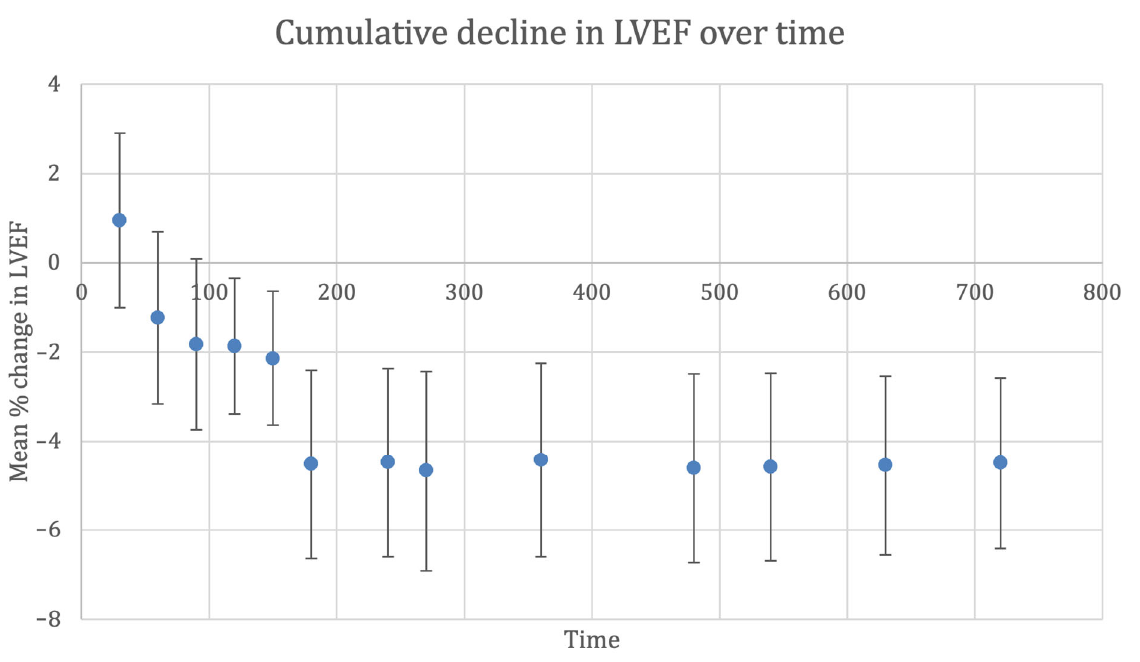
Figure 2. Cumulative decline in left ventricular ejection fraction (%) over time (days). Whiskers represent 95% confidence interval. Abbreviations: CI, confidence interval; LVEF, left ventricular ejection fraction.